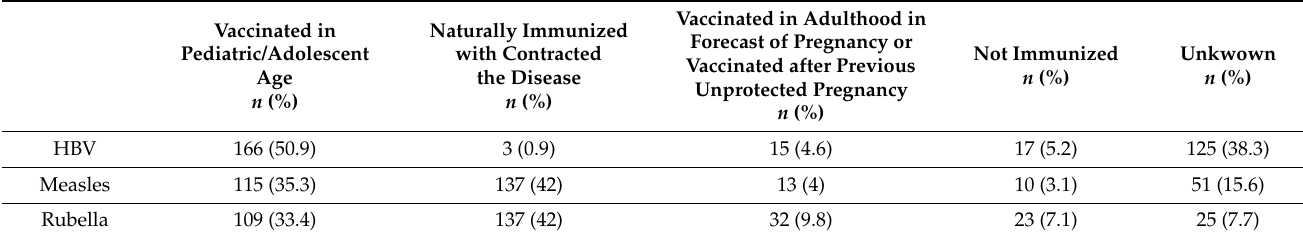
Table 2. Immunization status of the 326 pregnant women in study against the main virus vaccine preventable diseases (VPDs) at the time of questionnaire completion.